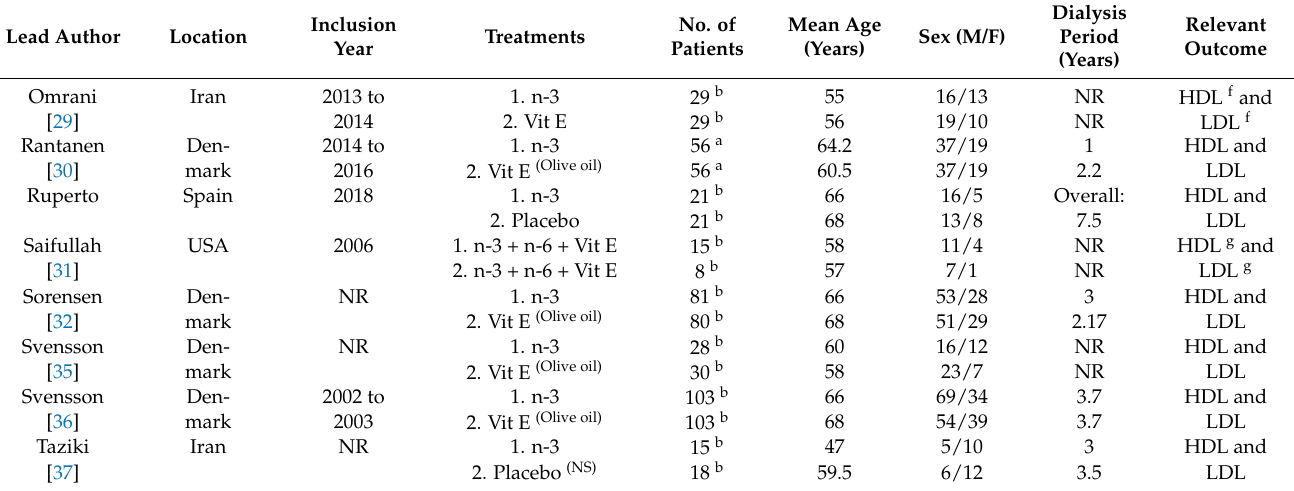
(Figure 2E). The design-by-treatment interaction model detected global inconsistencies among the included RCTs (Q statistics = 20.68; p < 0.05) and further design-specific decom- position within the designs showed potential threats in the comparison of placebo and n-3 + n-6 (Q statistics = 18.50; p < 0.05; File S4), while mean path length of the comparison did not reach critical threshold. The biggest concern among the significant findings was that mean path length between placebo and MCT passed the critical threshold (File S4). in the network meta-analysis of HDL (Figure